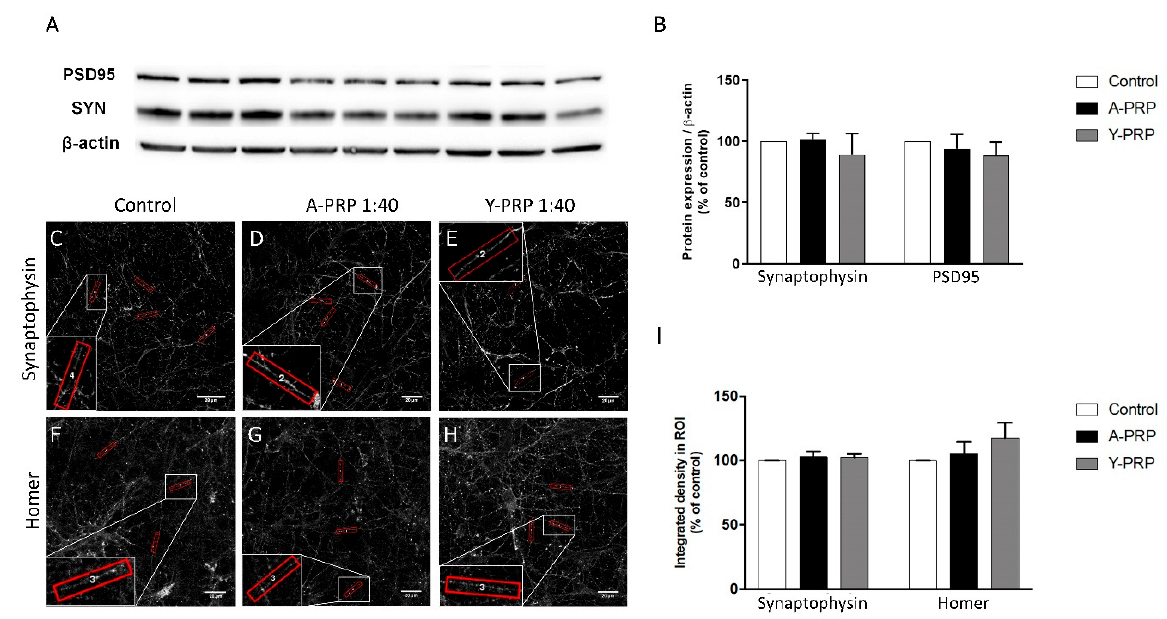
Figure 6. Synaptic protein expression. Protein expression of presynaptic (Synaptophysin) and postsynaptic (PSD-95) markers in neuronal cells treated in triplicate with control, Aged PRP, or Young PRP ( A ) and its quantification relative to the control treatment ( B ). ( C – H ) Immunohistochemical analysis of presynaptic (synaptophysin) and postsynaptic (Homer) markers in neuronal cells and its quantification by the integrated density in ROI relative to the control treatment ( I ). A-PRP: Aged PRP; Y-PRP: Young PRP. Error bars = standard deviation.